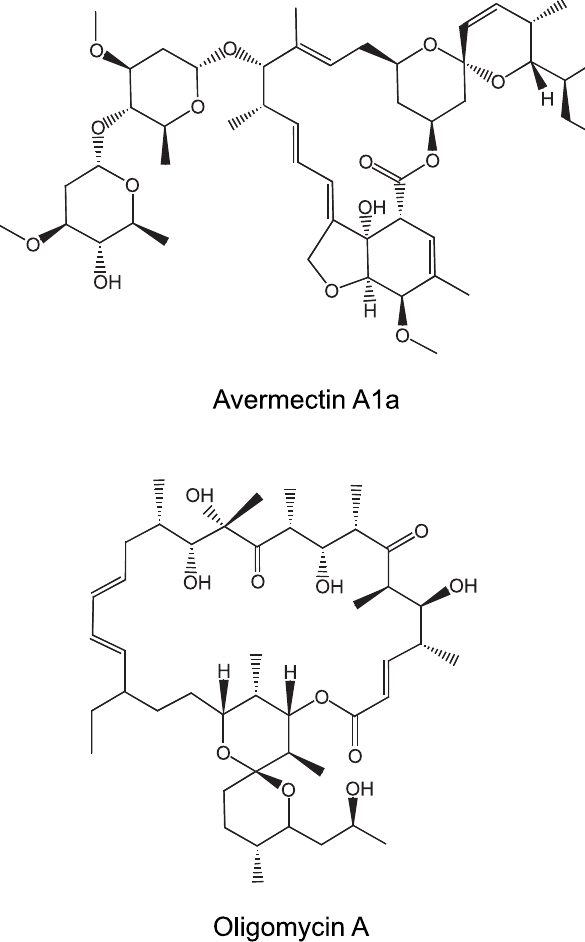
Figure 2. Representative Structures of Secondary Metabolites Classes Produced by the Large PKSs of S. avermitilis The avermectin and oligomycin structures are examples of the respective compound groups. The exact structure of the polyene macrolide compound is not known. DOI: